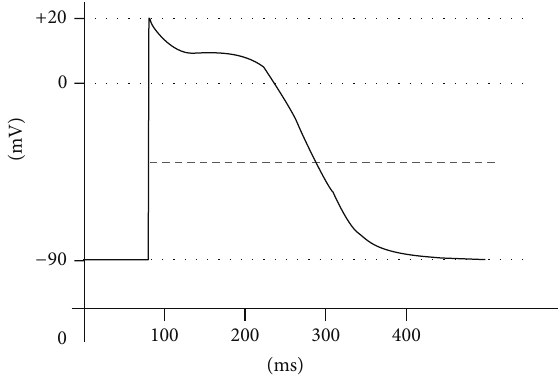
Figure 2: The cardiac action potentials.